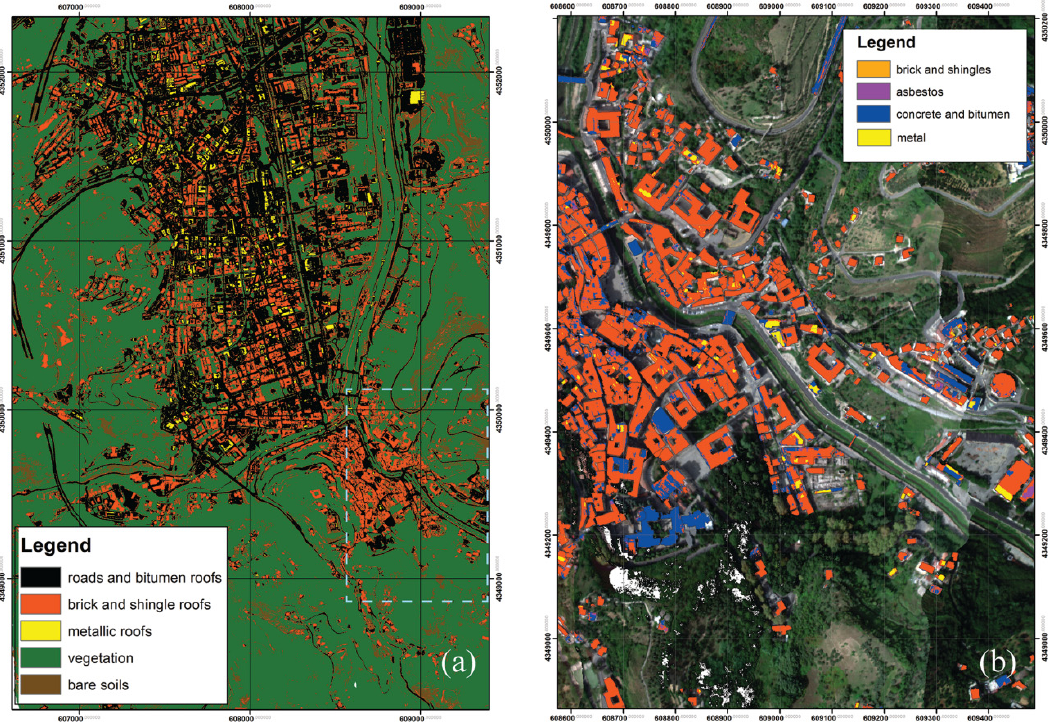
Figure 6. SAM-based supervised classification analyses of Cosenza. ( a ) Land-cover and land-use map; and ( b ) construction materials map of the building roofs.